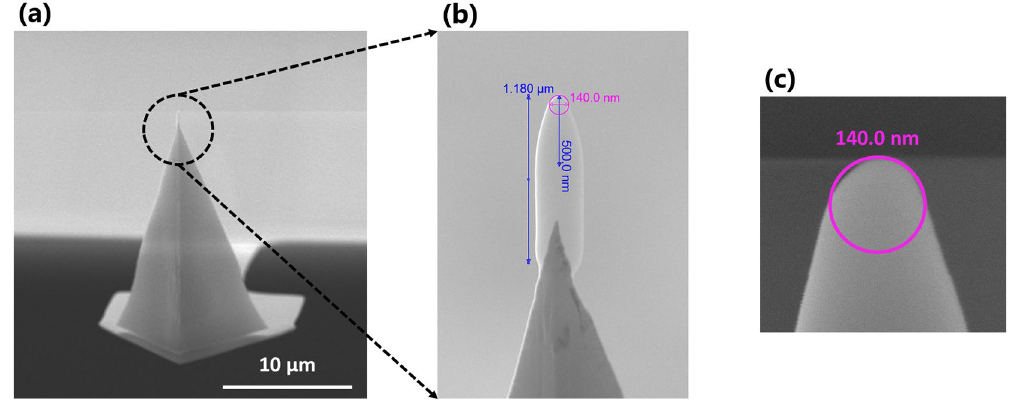
Figure 1. SEM images of the specially designed AFM probe used in the nanoindentation